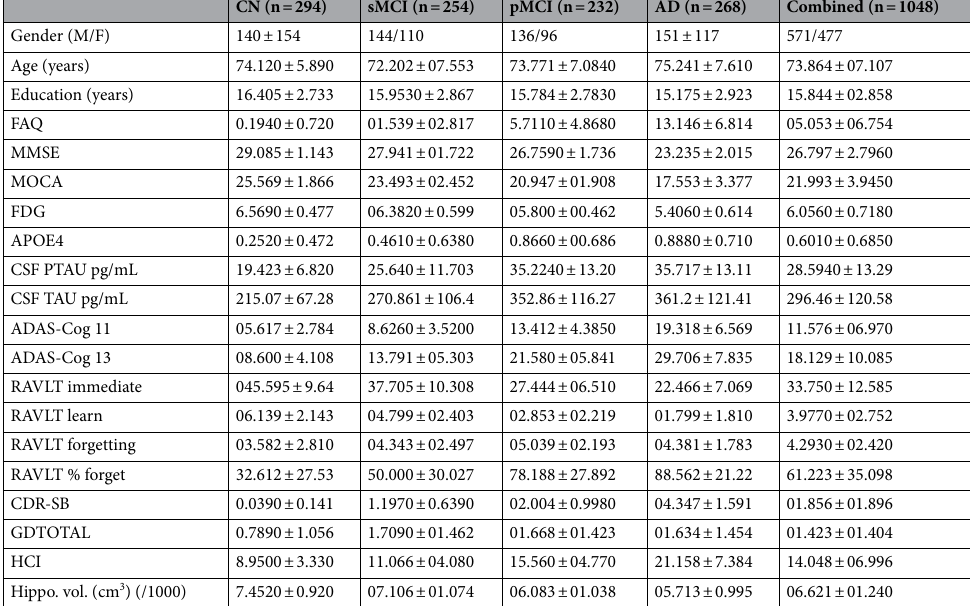
Table 11. Descriptive statistics from the dataset used. AD, Alzheimer’s disease; MCI, mild cognitive impairment; pMCI-sMCI, progressive MCI – stable MCI; CN, cognitive normal; CDR, clinical dementia rating; ADAS-Cog, Alzheimer’s Disease Assessment Scale–Cognitive Subscale test; RAVLT, Rey Auditory Verbal Learning Test; FAQ, Functional Assessment Questionnaire; MMSE, Mini–Mental State Examination; FDG, sum of mean glucose metabolism uptake in regions of angular, temporal, and posterior cingulate; TAU, CSF level of TAU; Aβ42, CSF level of amyloid β1–42 peptide; HCI, hypometabolic convergence index; AV45, Average AV45 SUVR of frontal, anterior cingulate, precuneus, and parietal cortex relative to the cerebellum; Hippo, Hippocampus; GDTOTAL, Geriatric Depression Scale. *Data are mean ± standard